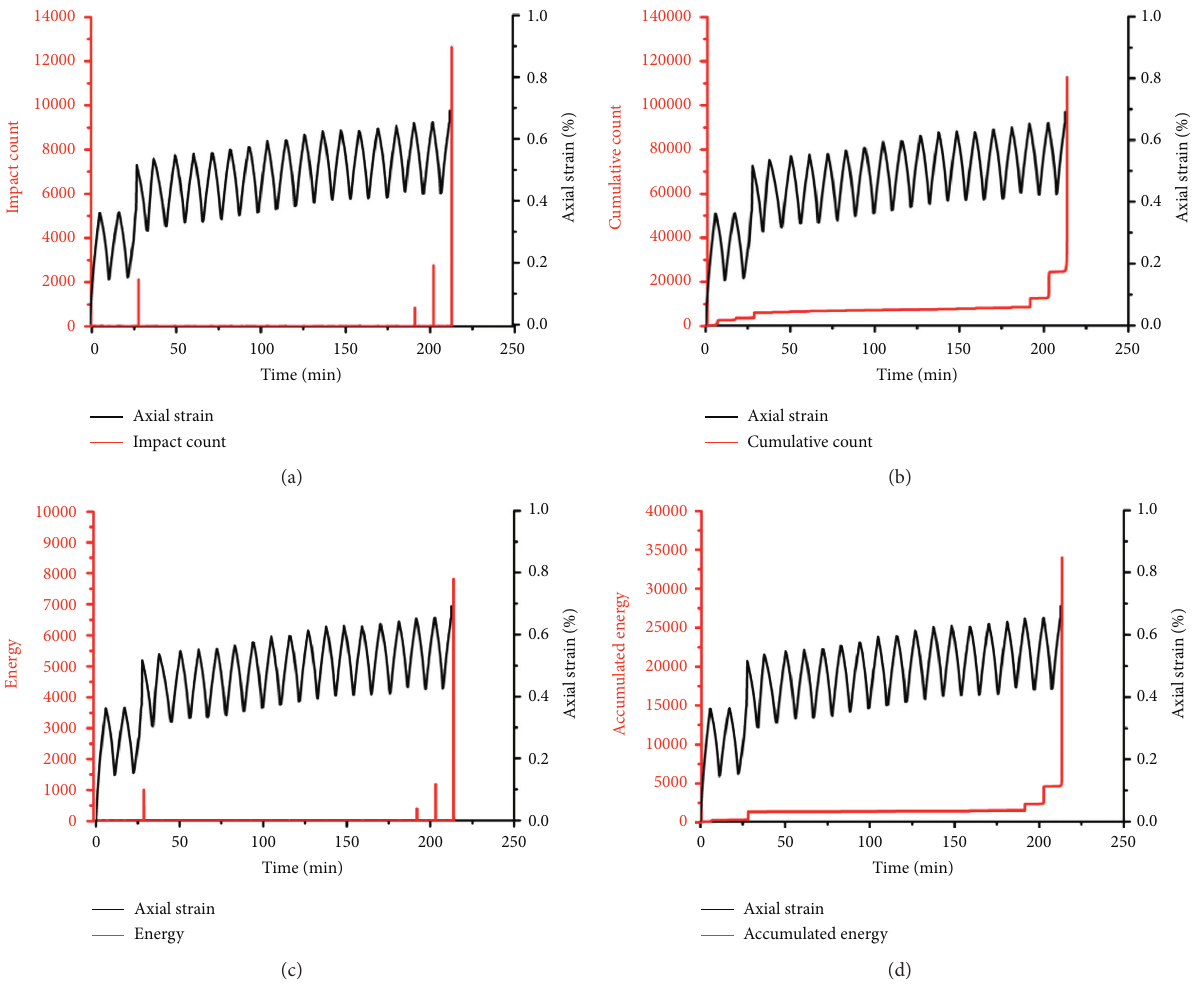
Figure 16: Deformation and acoustic emission characteristics of S-2-2 sample. (a) The curves of ringing count and axial strain of S-2-2 sample with time. (b) The curves of cumulative ringing count and axial strain of S-2-2 sample with time. (c) The curves of energy and axial strain of S-2-2 sample with time. (d) The curves of cumulative energy and axial strain of S-2-2 sample with